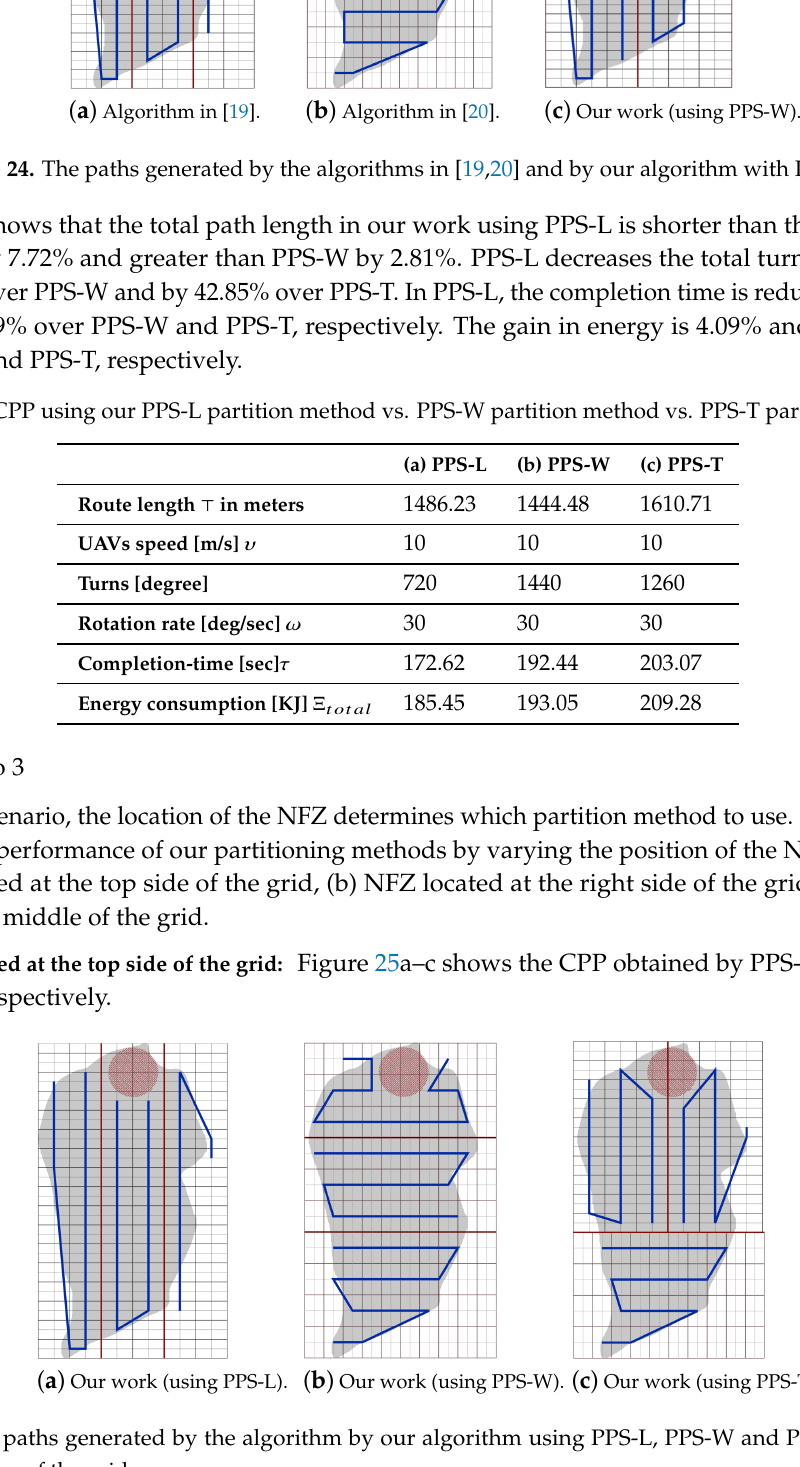
( a ) Algorithm in [19]. ( b ) Algorithm in [20]. ( c ) Our work (using PPS-W). Figure 24. The paths generated by the algorithms in [19,20] and by our algorithm with PPS-W.